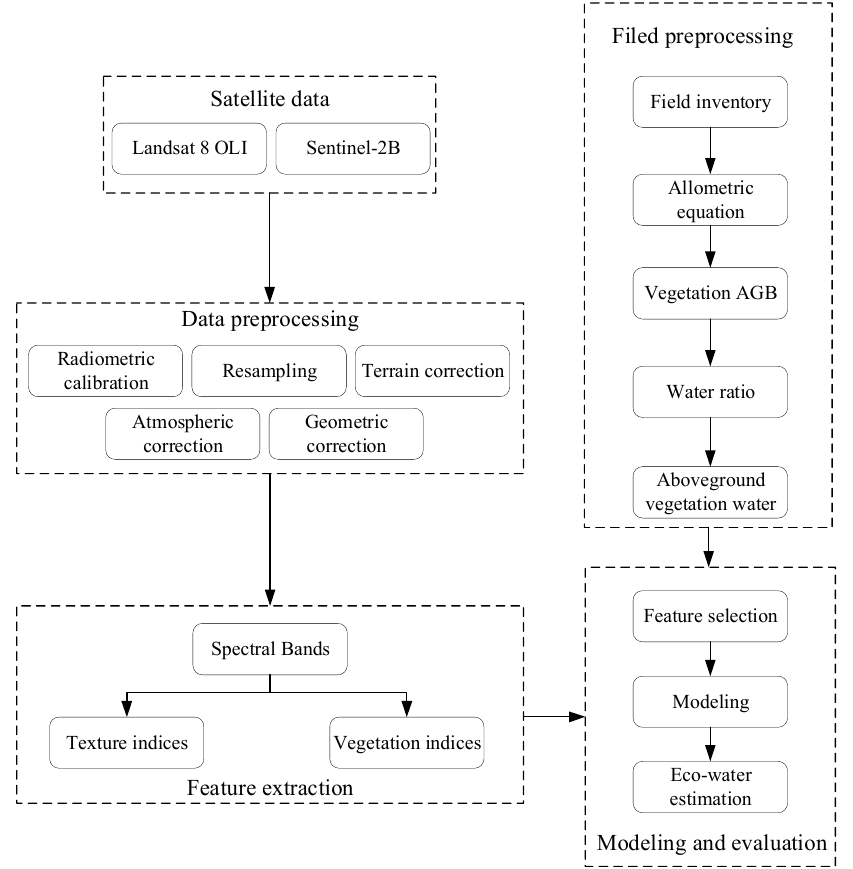
Figure 2. Workflow of the AVWS (aboveground vegetation water storage) estimation model.